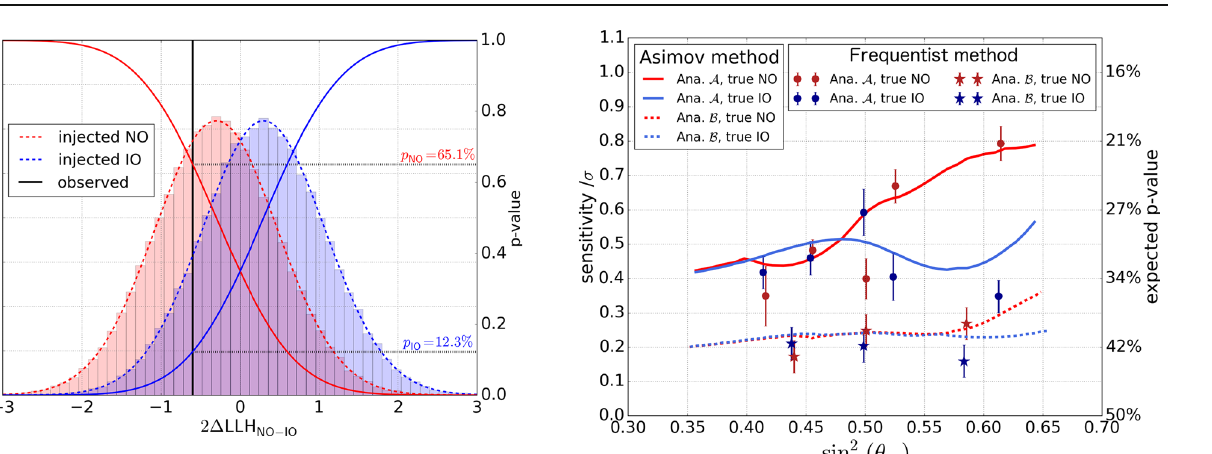
{ η NO , η IO } used for H